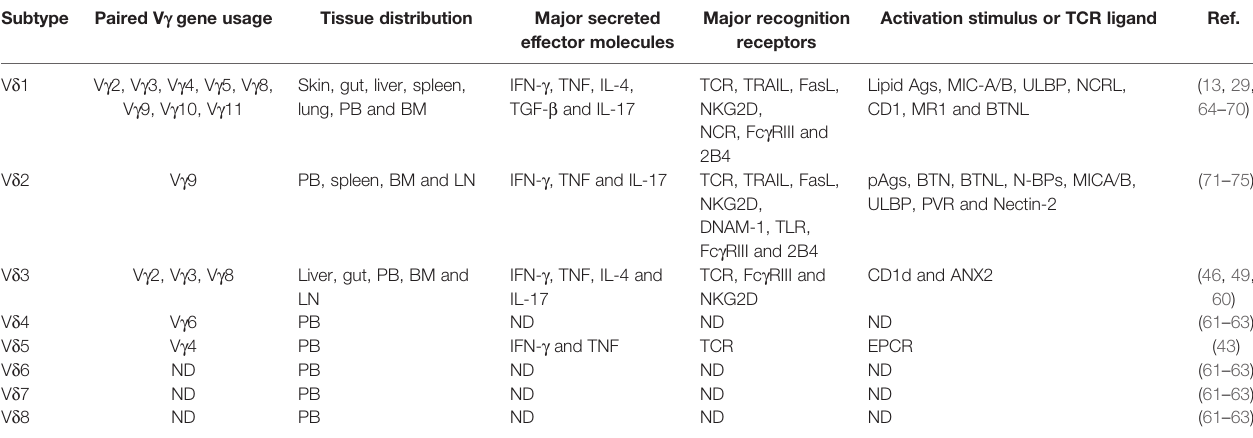
TABLE 1 | Diversity of human gd T